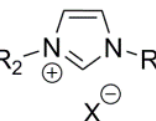
Figure 1. The general formula of imidazolium salts.